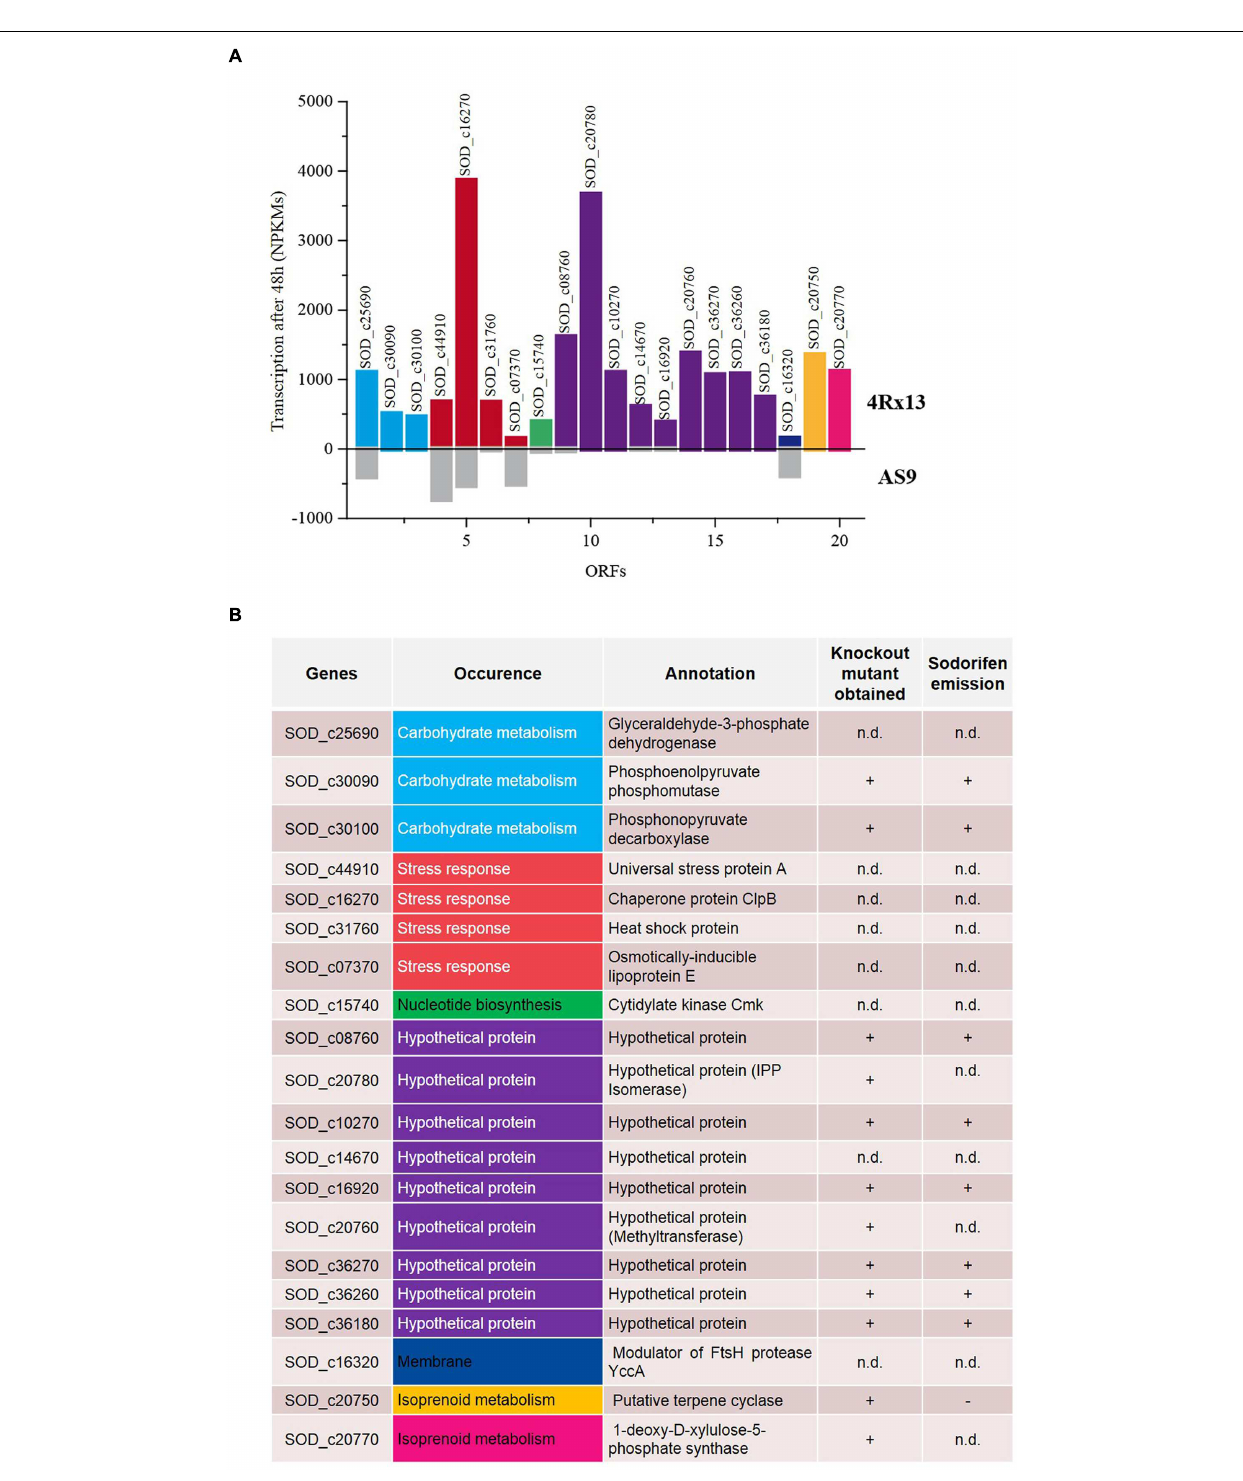
Frontiers in Microbiology |